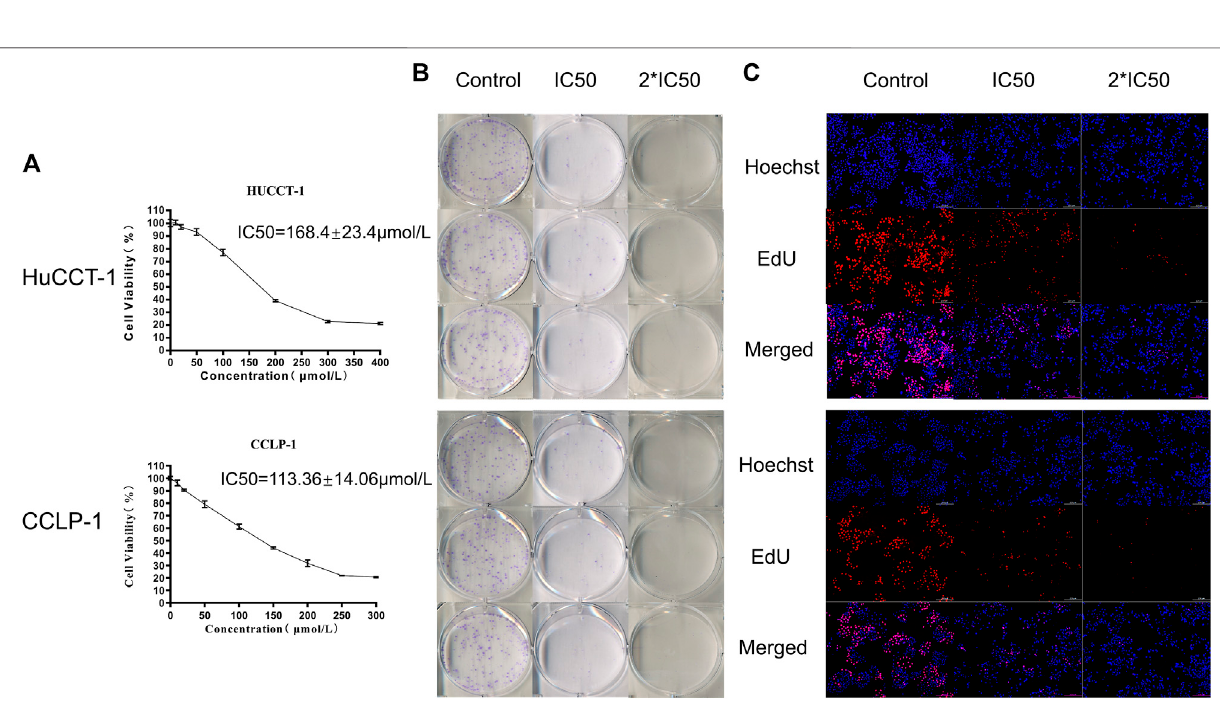
Frontiers in Molecular Biosciences |